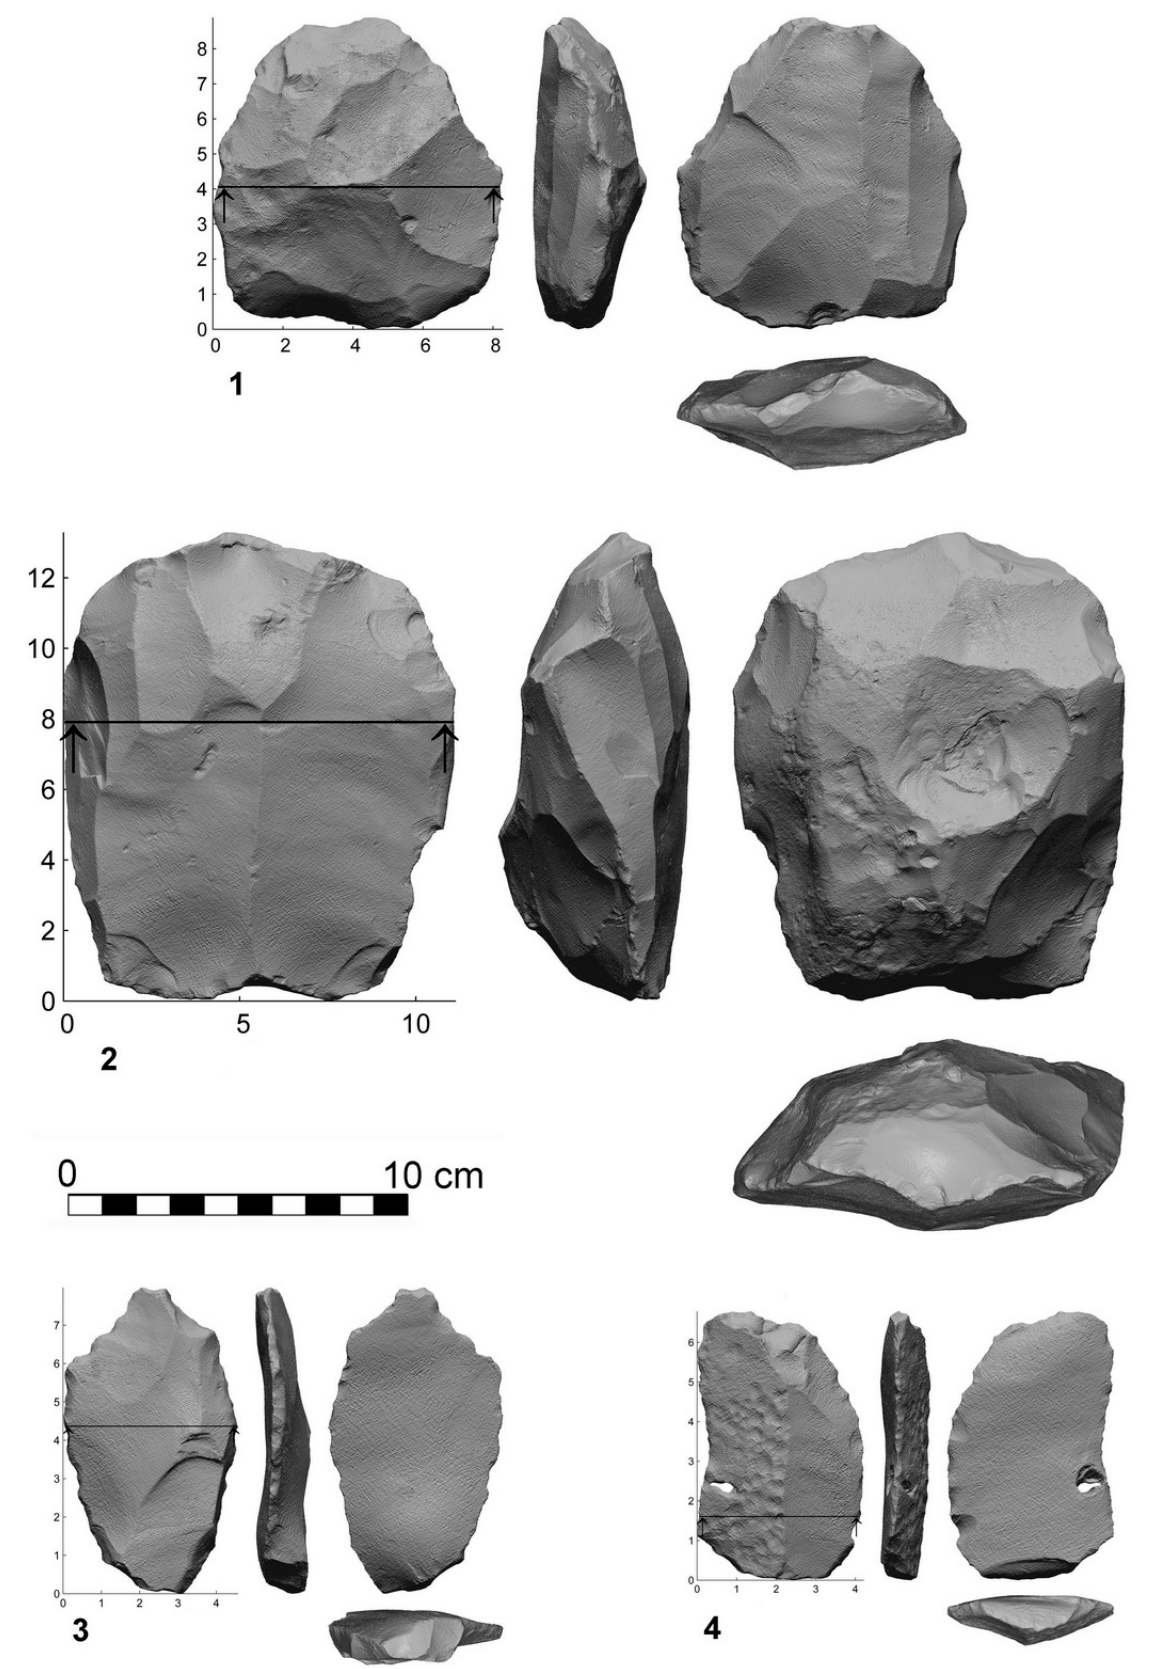
Figure 5. Nahal Zihor 6 - 3D scans of artifacts - 1,2 Levallois cores, 3,4 Large